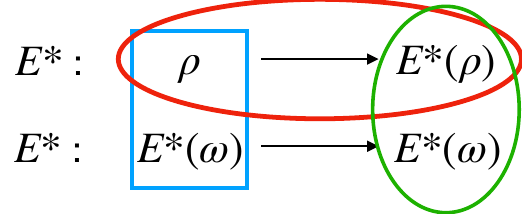
Figure 4. A pictorial description of the relative entropy property in equation (2.27) written in terms of states of F . The relative entropy of blue states S ( (cid:26) jj E (cid:3) ( ! )) is the relative entropy the red ellipse S ( (cid:26) k E (cid:3) ( (cid:26) )) plus the relative entropy of the green ellipse S ( E (cid:3) ( (cid:26) ) k E (cid:3) ( ! )). Note that since both E (cid:3) ( (cid:26) ) and E (cid:3) ( ! ) are invariant under E , the green relative entropy is the same as S A ( (cid:26) k E (cid:3) ( !